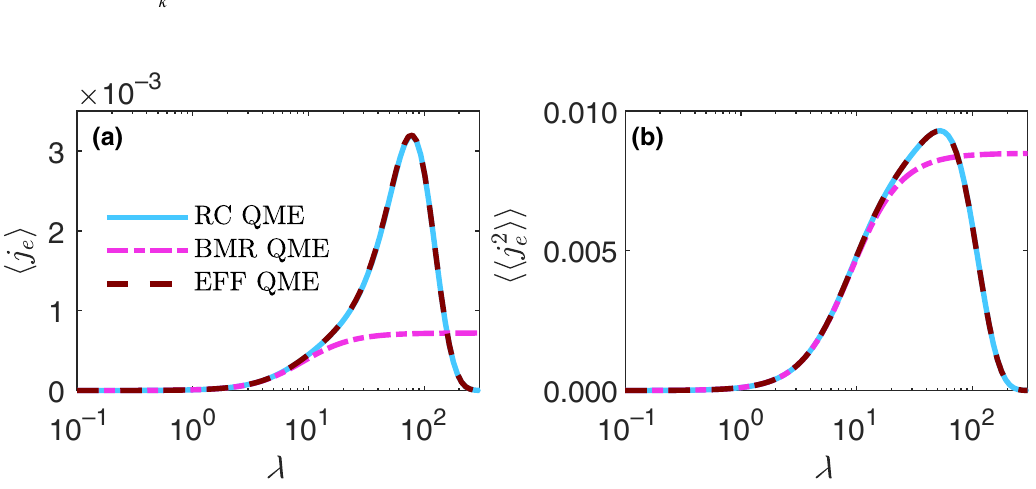
FIG. 9. A phonon-assisted quantum dot thermoelectric power generator. (a) The mean steady-state charge current flowing left to right (positive) and (b) the current fluctuations. The parameters are (cid:18) R = 2, (cid:18) L = 0, T L = 10, T R = 1, (cid:5) = 100, μ L = − 0.3 μ R = − μ = 0.1, T = 1, and 2 πγ (cid:5) = 100 and the metal-dot hybridization energies are (cid:14) − 0.2, V = μ ph R L of T R